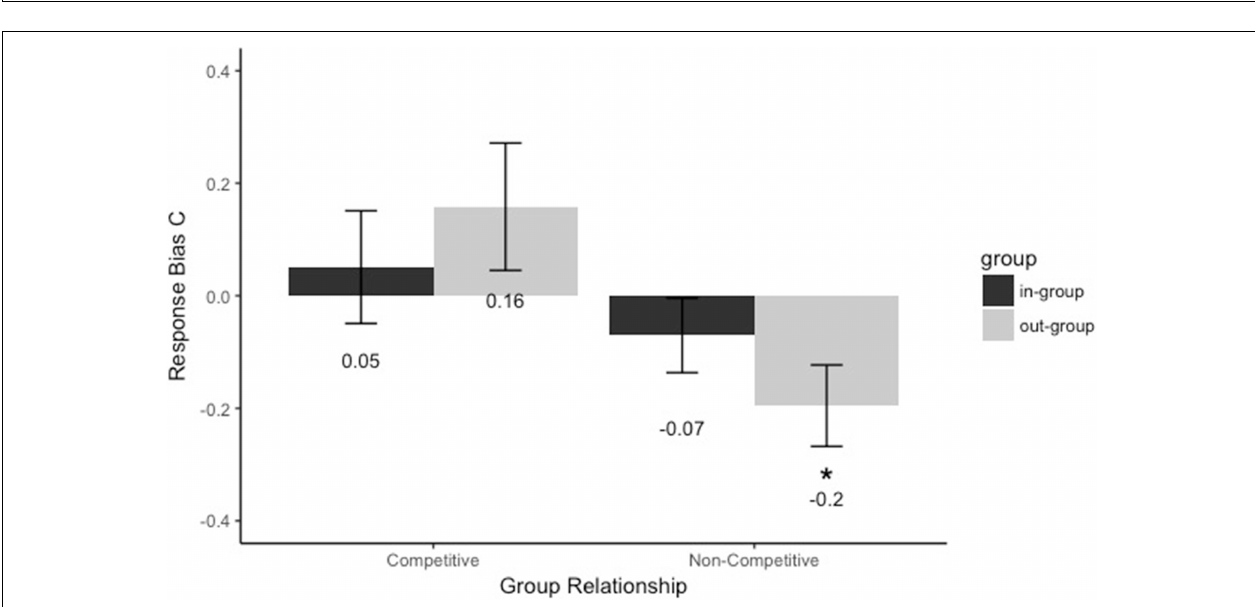
FIGURE 2 | Recognition accuracy (d’) for faces assigned to the different groups with and without competitive cues. Black bars refer to in-group members, and gray bars refer to out-group members. Error bars represent standard errors (* p < 0.05 and *** p < 0.001).